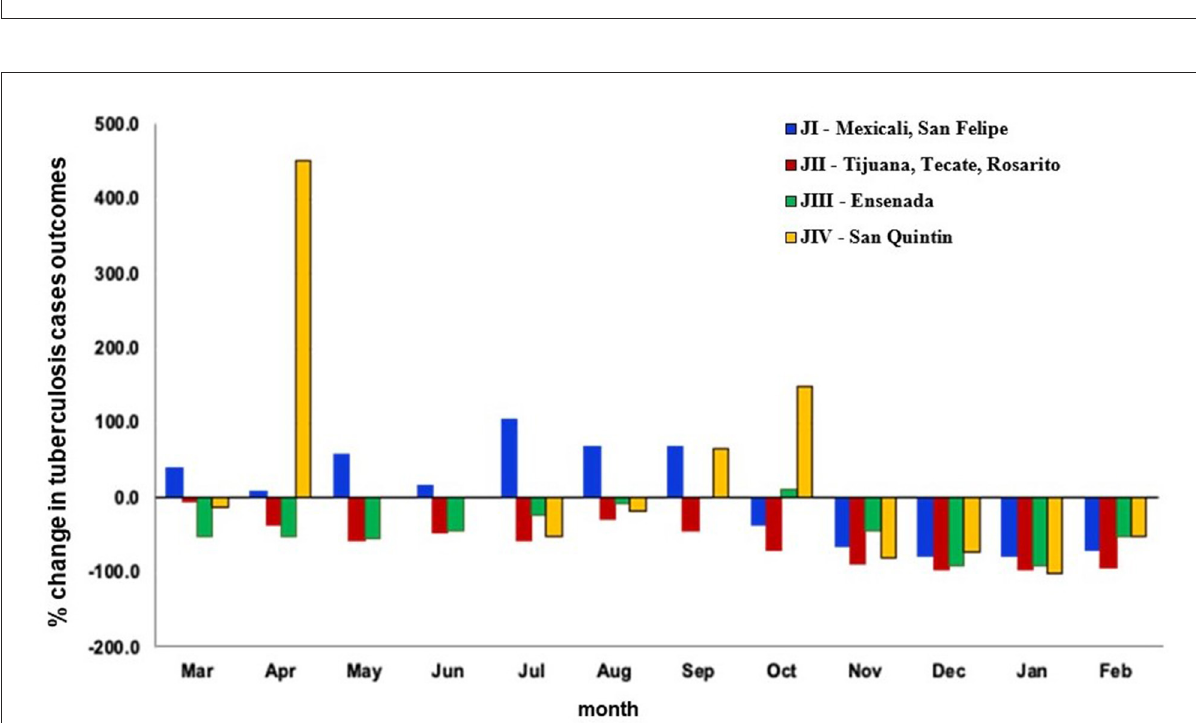
FIGURE4 Number of tuberculosis treatment outcomes by month in the year before and the first year during the COVID-19 pandemic, Baja California, México, 2019–2021. Data source: Mexico Ministry of Health management information system (https://tuberculosis.sinave.gob.mx/).